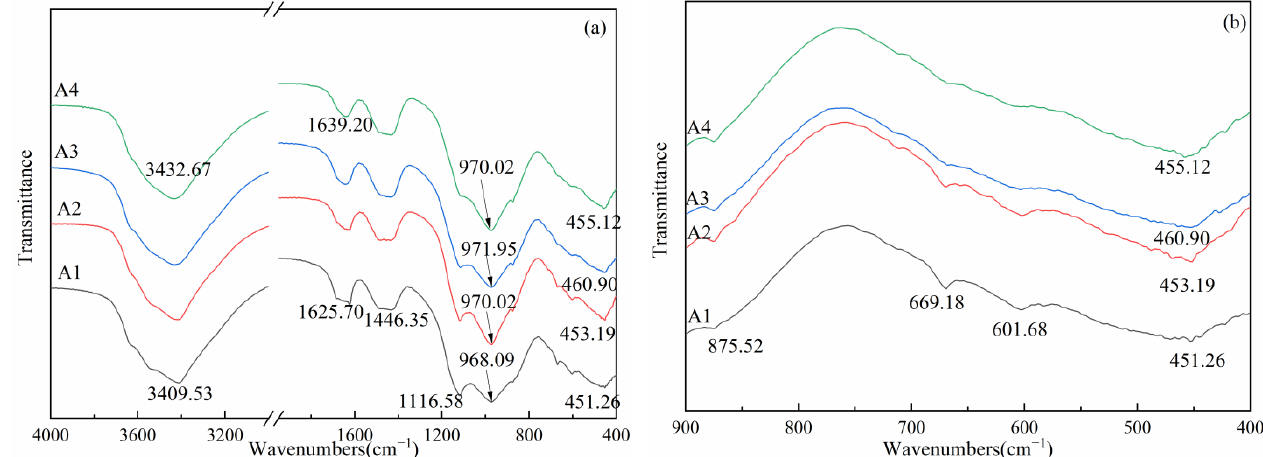
Figure 7. FTIR spectra of the samples with different ASR-to-DG ratios at 180 days: ( a ) full-range FTIR; ( b ) range from 400 to 900 cm –1 .